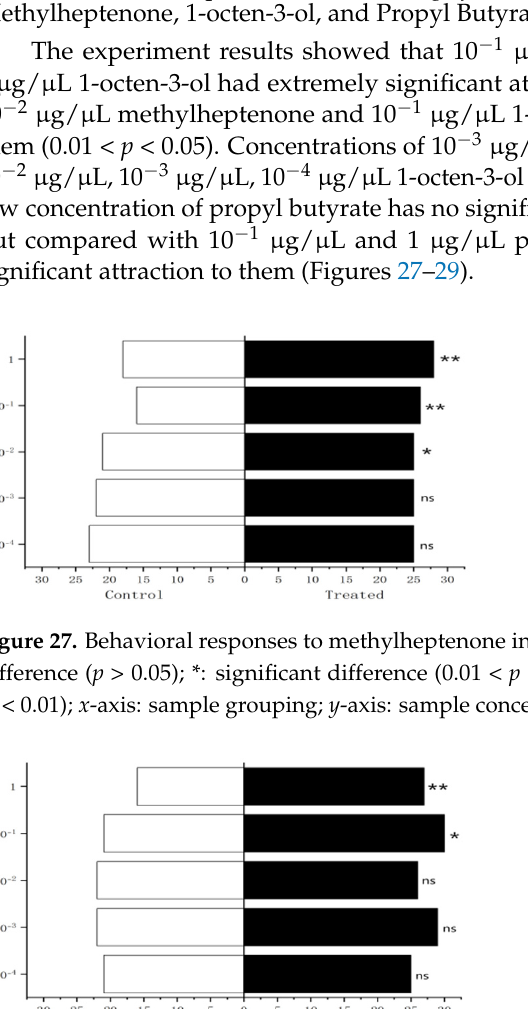
Figure 26. Comparison of EAG responses of W. magnifica to propyl butyrate.